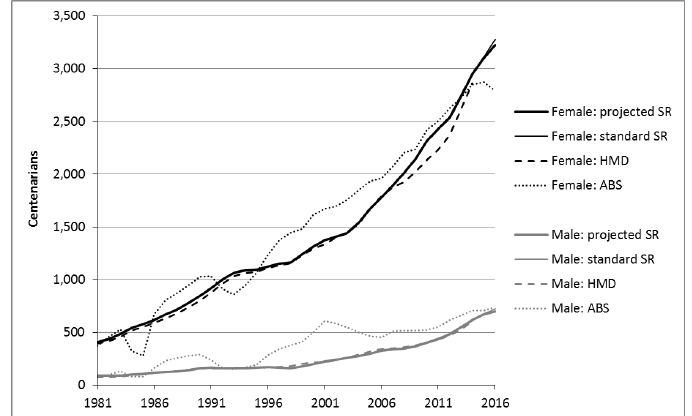
Figure 7: Comparison of centenarian estimates for Australia, 1981-2016